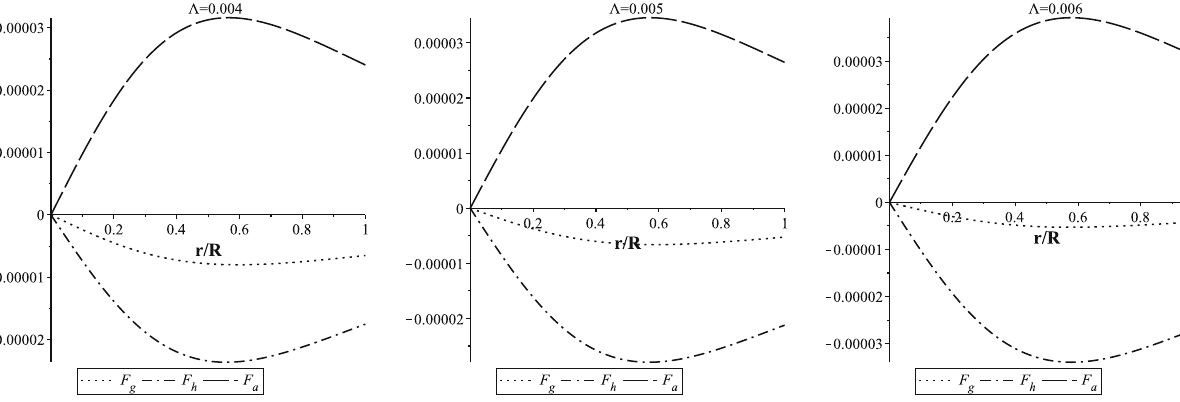
Fig. 7 Behavior of different forces for Λ = 0 . 004 (left panel), Λ = 0 . 005 (middle panel) and Λ = 0 . 006 (right panel) as a function of the fractional radial distance for the strange star candidate LMC X − 4 are shown